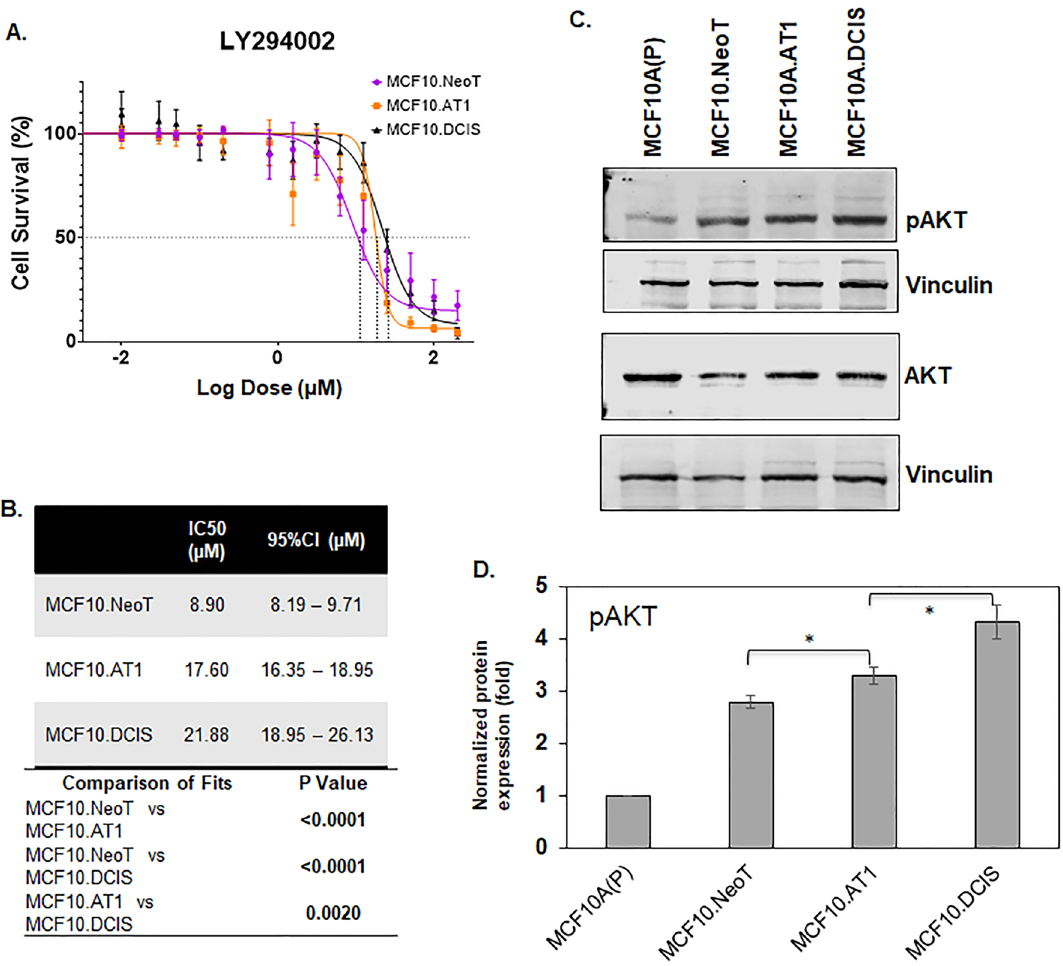
Figure 2. Aberrant activation of the AKT-mTOR pathway at baseline is associated with lower efficacy of a PI3K inhibitor. ( A ) Cell survival curves as measured by MTT assay show inhibition in proliferation of MCF10.NeoT, MCF10.AT1 and MCF10.DCIS cells by PI3K inhibitor LY294002. ( B ) Table shows the concentrations (in µM, with 95% confidence intervals [95%CI]) that cause 50% inhibition in cell survival (IC50) for each cell line and their statistical significance. A p value < 0.05 was considered statistically significant. ( C ) Western blot and ( D ) its quantification show upregulation of pAKT in the MCF10A breast cancer progression panel. pAKT expression was normalized to vinculin and total AKT levels. The same vinculin or β-actin bands may be shown for multiple proteins (and figures) if they came from the same membrane. Bar diagram: average values ± standard error of the mean (SEM). *p <